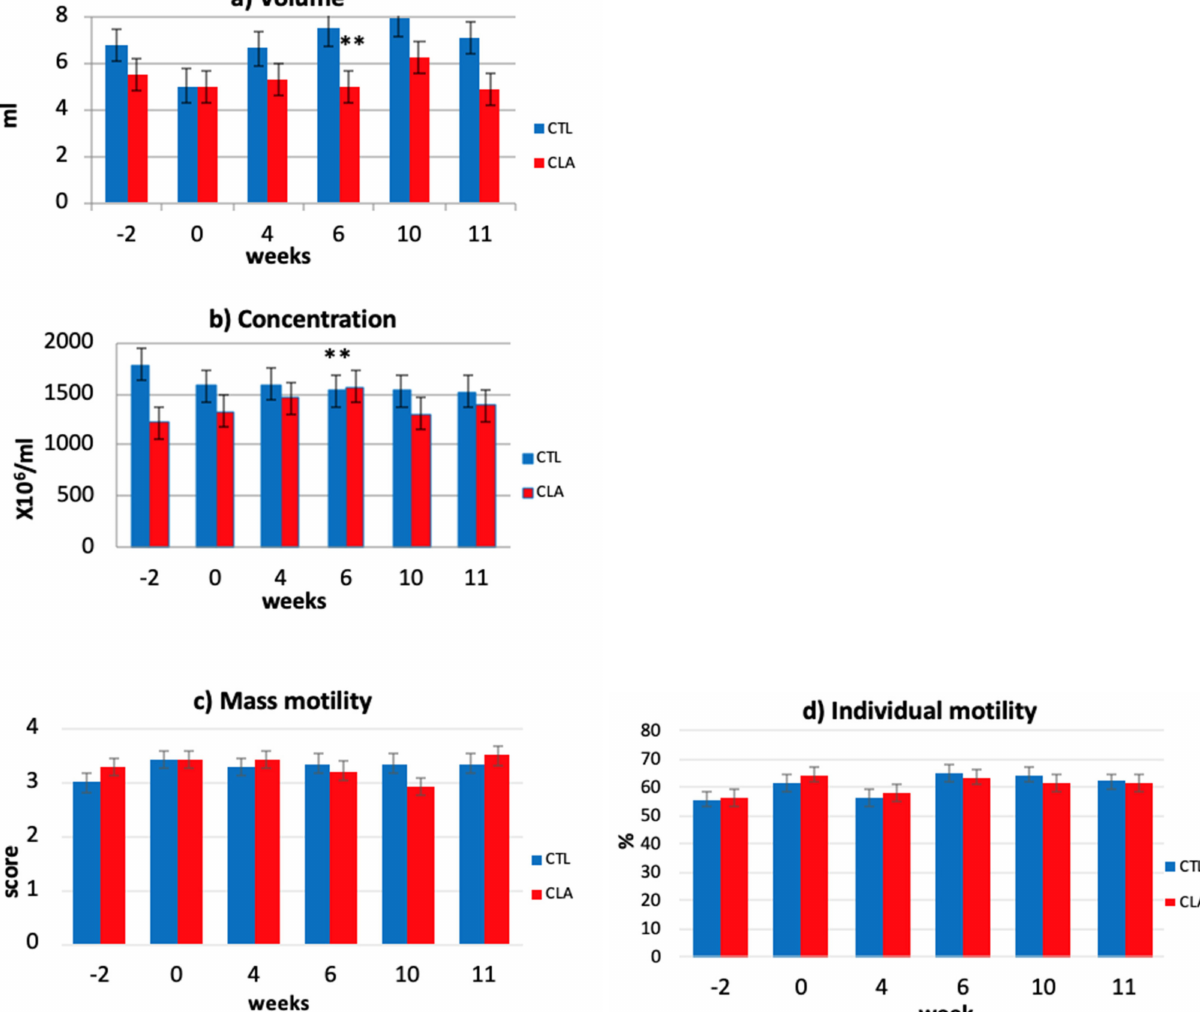
Figure 2. Effect of CLA dietary supplementation on fresh ejaculated bovine semen volume measured using graduated glass conical tubes ( a ); concentration determined by SDM 6, Minitube © ( b ); and mass motility ( c ) and individual motility ( d ) estimated using a phase-contrast microscope (Nikon © ) (LSM ± SE) for the control (CTL) and CLA group. ** significant levels trt × week: p ≤